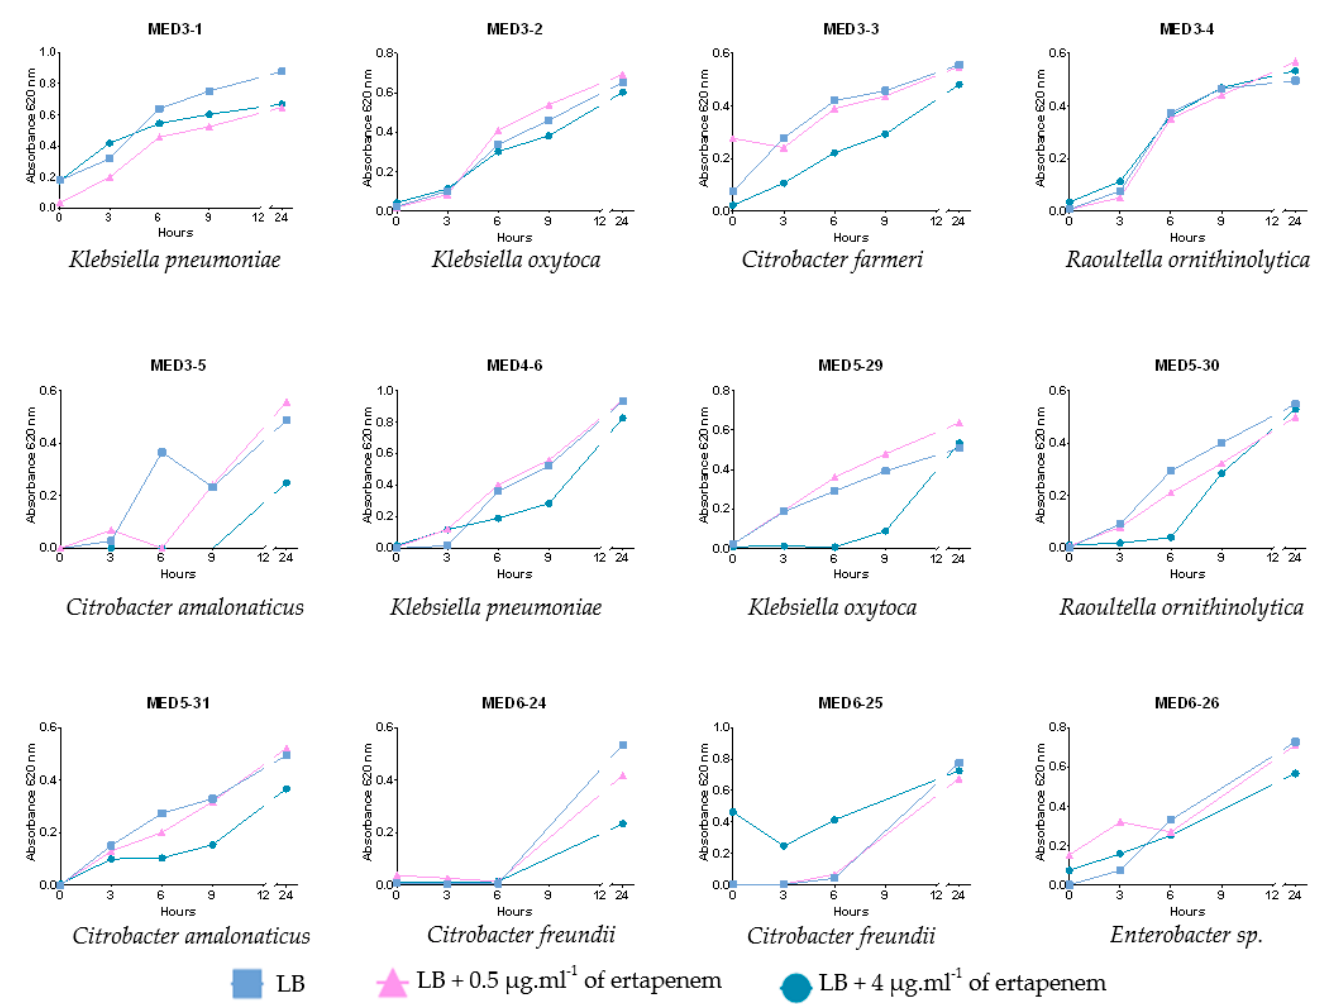
Figure 2. Growth over time according to the ertapenem concentration (0, 0.5 or 4 µ g · mL − 1 ) and species identification of presumptive carbapenemase-producing- carbapenem-resistant-Enterobacterales isolated from MED3, MED4, MED5, and MED6.